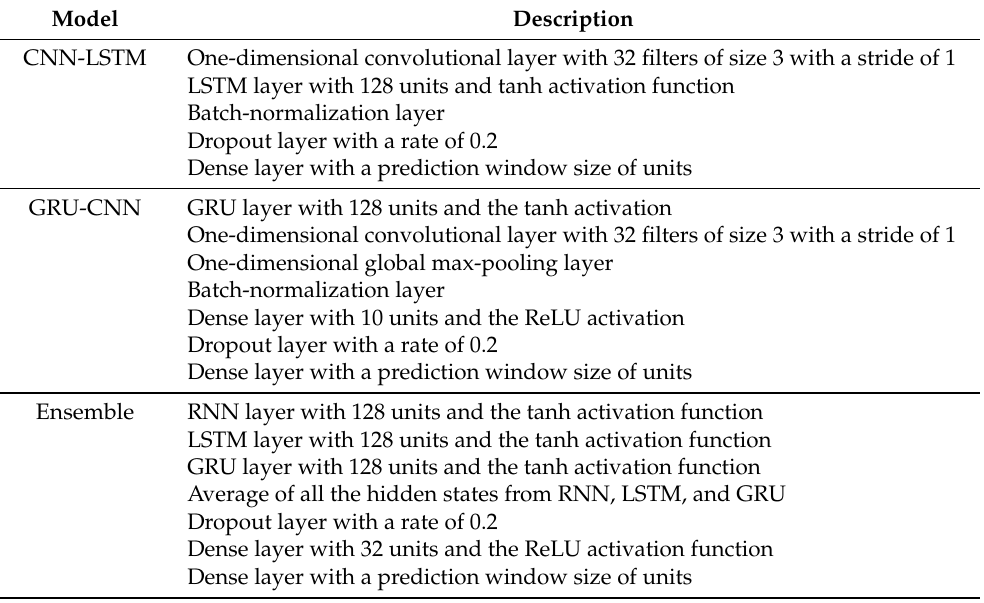
Figure 1. ( a ) Architecture of the CNN-LSTM model. ( b ) Architecture of the GRU-CNN model. ( c ) Ar- chitecture of the ensemble model. Table 1. Model configuration of the proposed